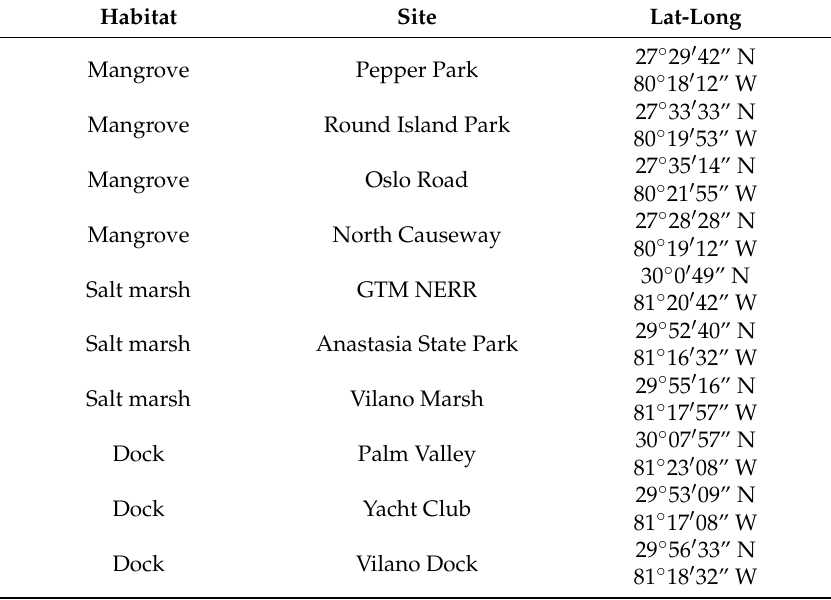
Table 1. Location and habitat of collection